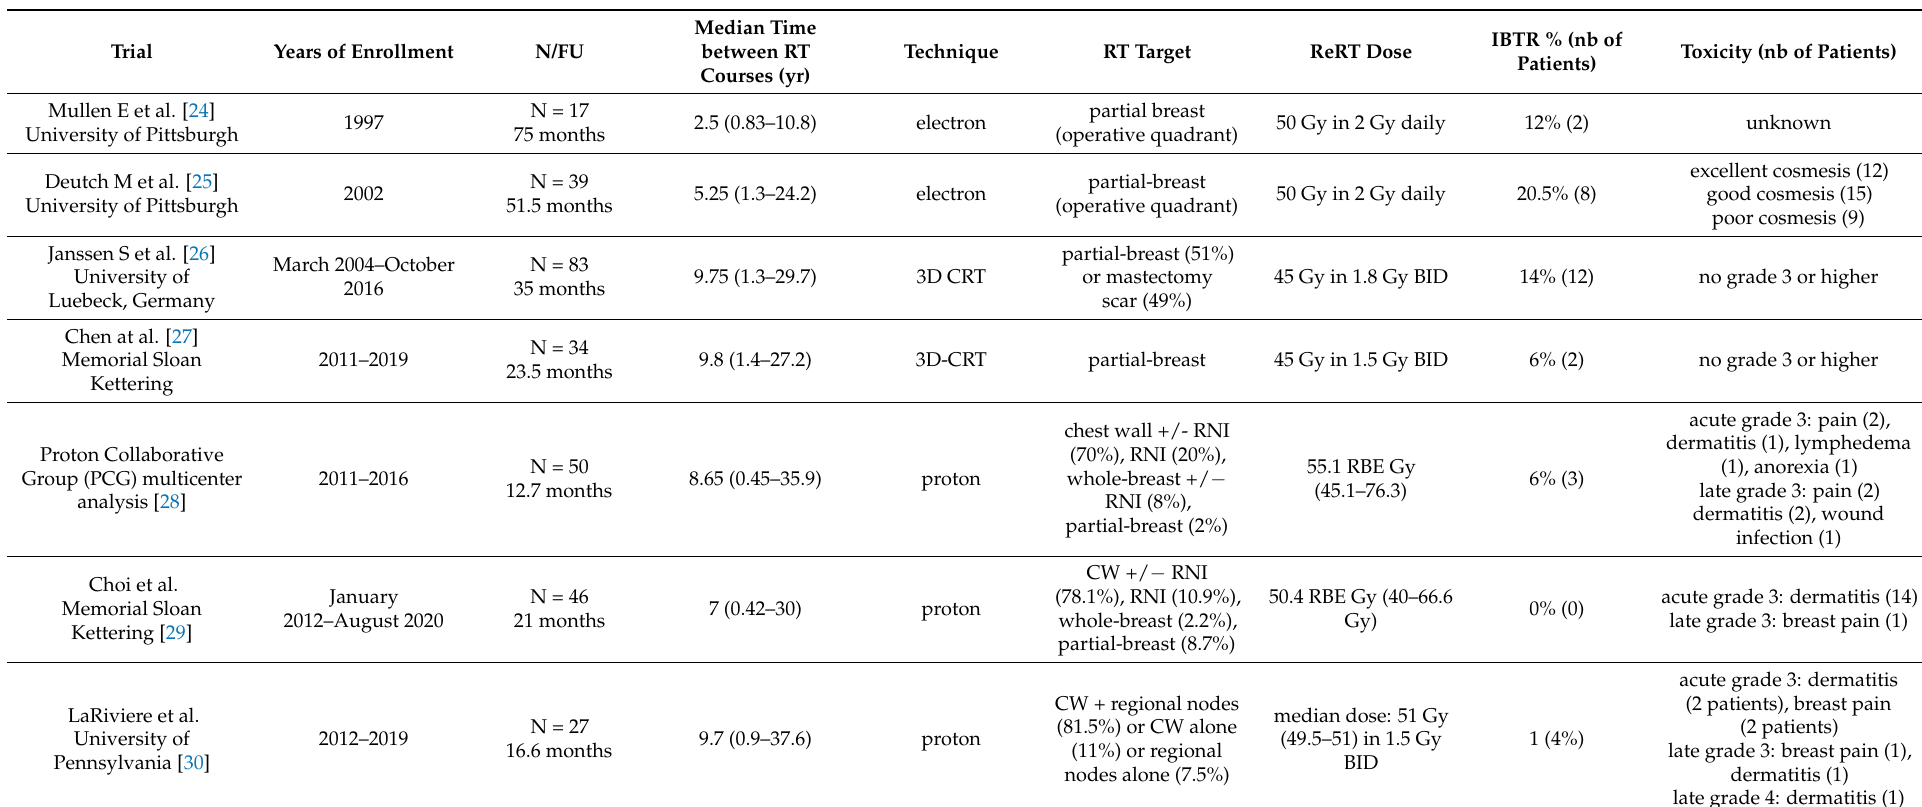
Table 2. Retrospective studies using external beam radiation therapy corresponds to Section 3.2 in